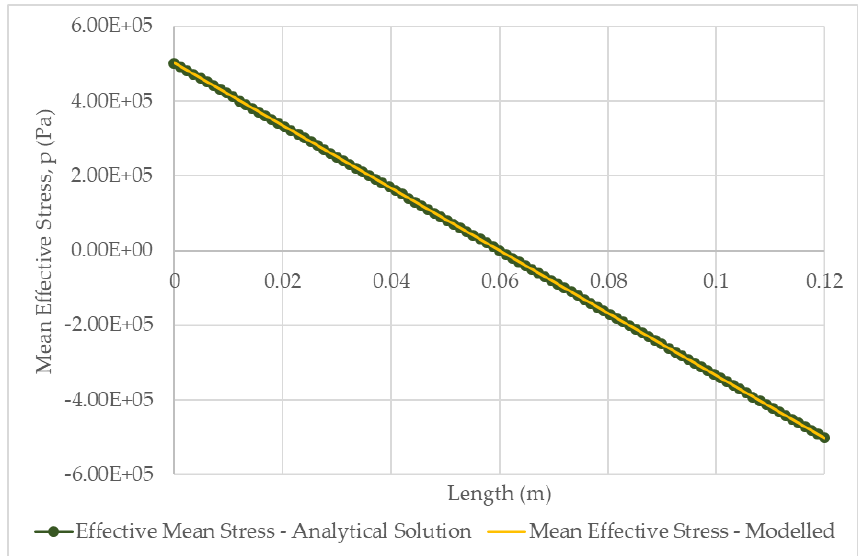
Figure 5. Verification study — 1D steady-state solution results for mean effective stress over the length of the specimen.